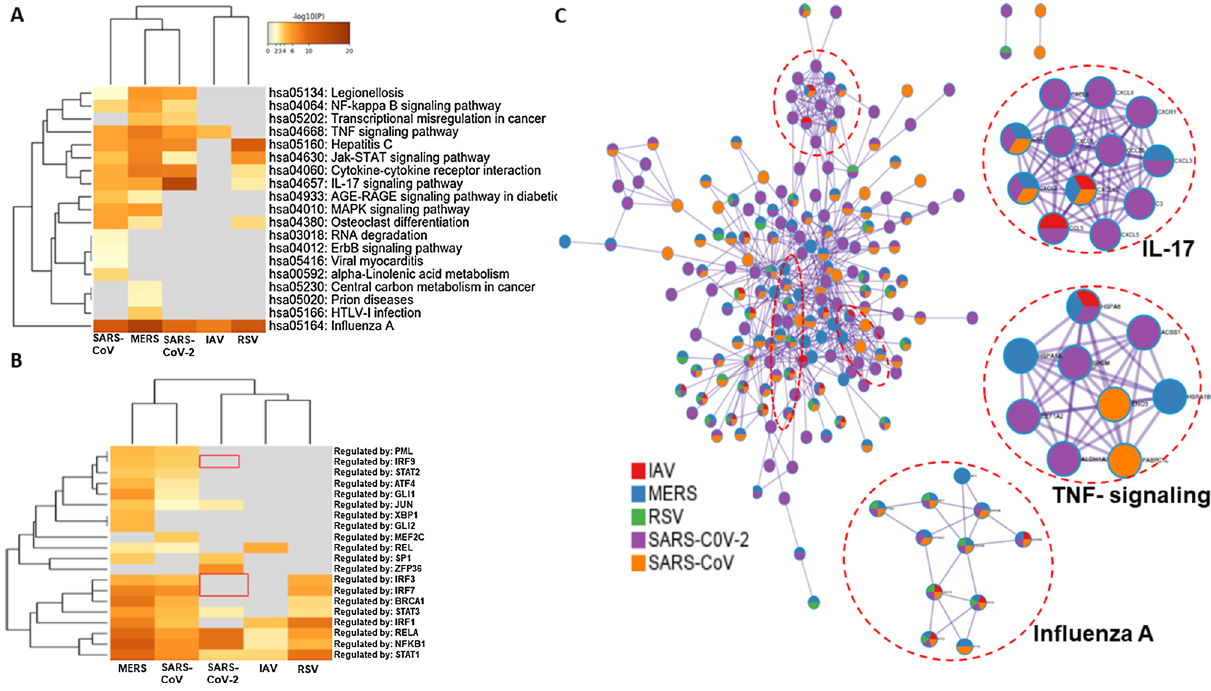
Figure 5. SARS-CoV-2 distinctively activates NF- κ B- but not IRF-mediated signaling. ( A ) Hierarchical clustering of the top most enriched terms in KEGG pathway by genes significantly upregulated upon SARS-CoV, SARS-CoV-2, MERS, RSV and IAV infection. ( B ) Hierarchical clustering of the top most enriched transcription factors for significantly upregulated genes using TRRUST database. Dendogram is colored by the p values, and grey cells indicate the lack of significant enrichment. ( C ) Enrichment network visualization for results from all datasets, where nodes are represented by pie charts with color codes depicting their designated datasets.